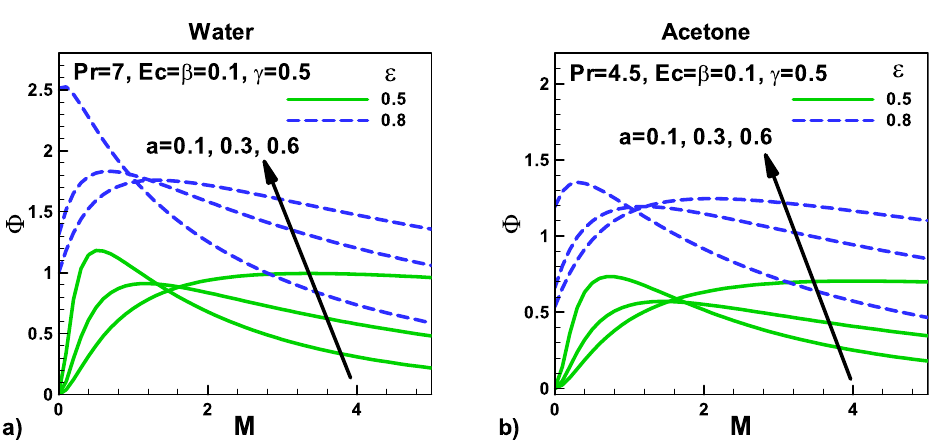
Figure 16. Variation of Irreversibility ratio with magnetic field and velocity ratio parameter at different positions for ( a ) water ( b )